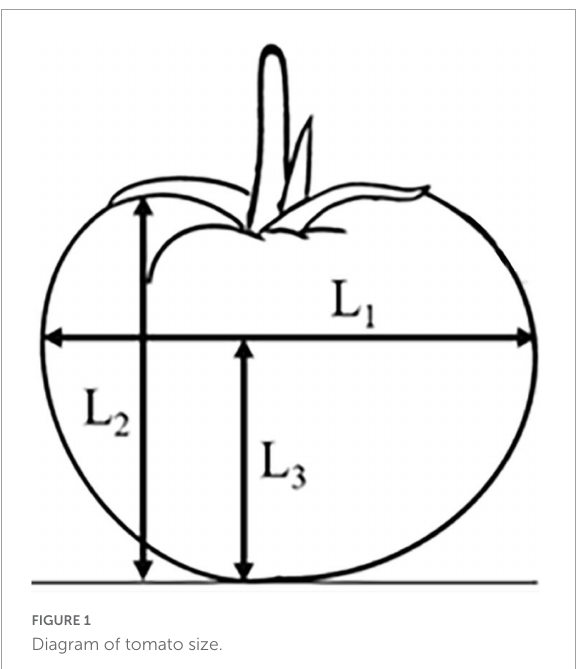
FIGURE1 Diagram of tomato